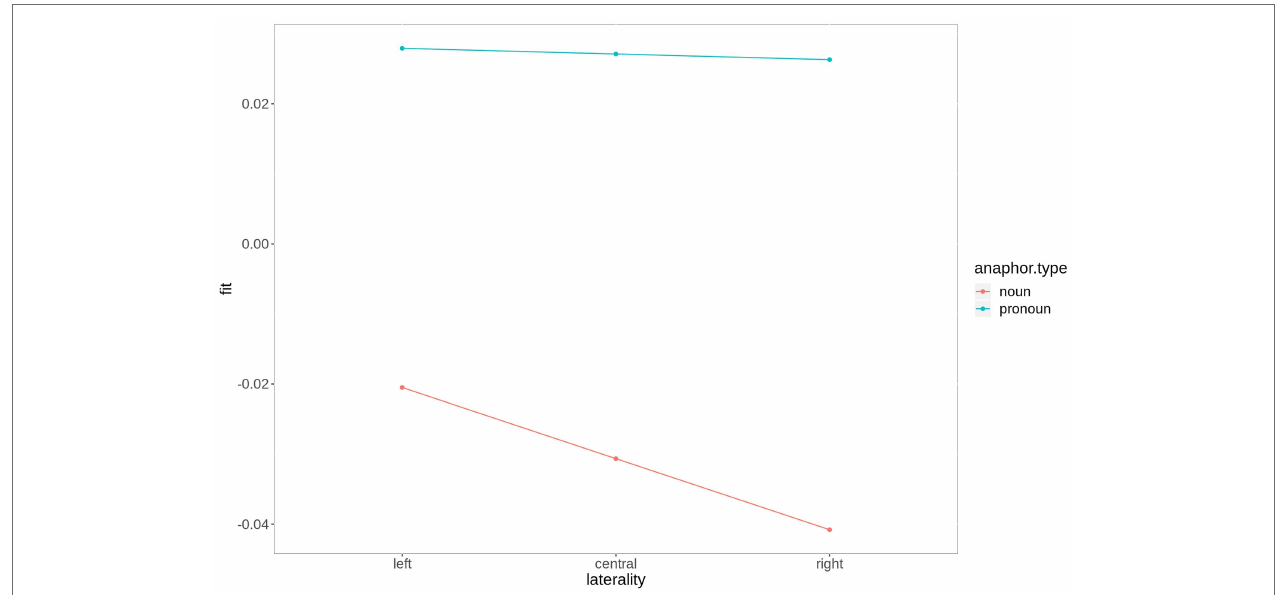
FIGURE 6 | Fitted values for the interaction laterality*anaphor type in the N400 time window. For plotting purposes, the continuous variable laterality was grouped into ROIs based on two-dimensional coordinates.